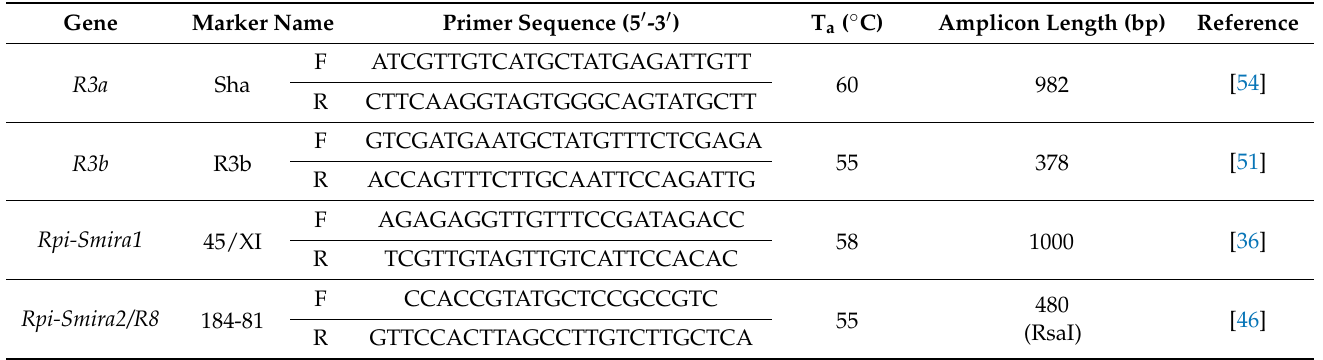
Table 2. Primers used for PCR amplification of genetic markers for plant selection of R8 genotypes, annealing temperatures (Ta), and amplicon length.